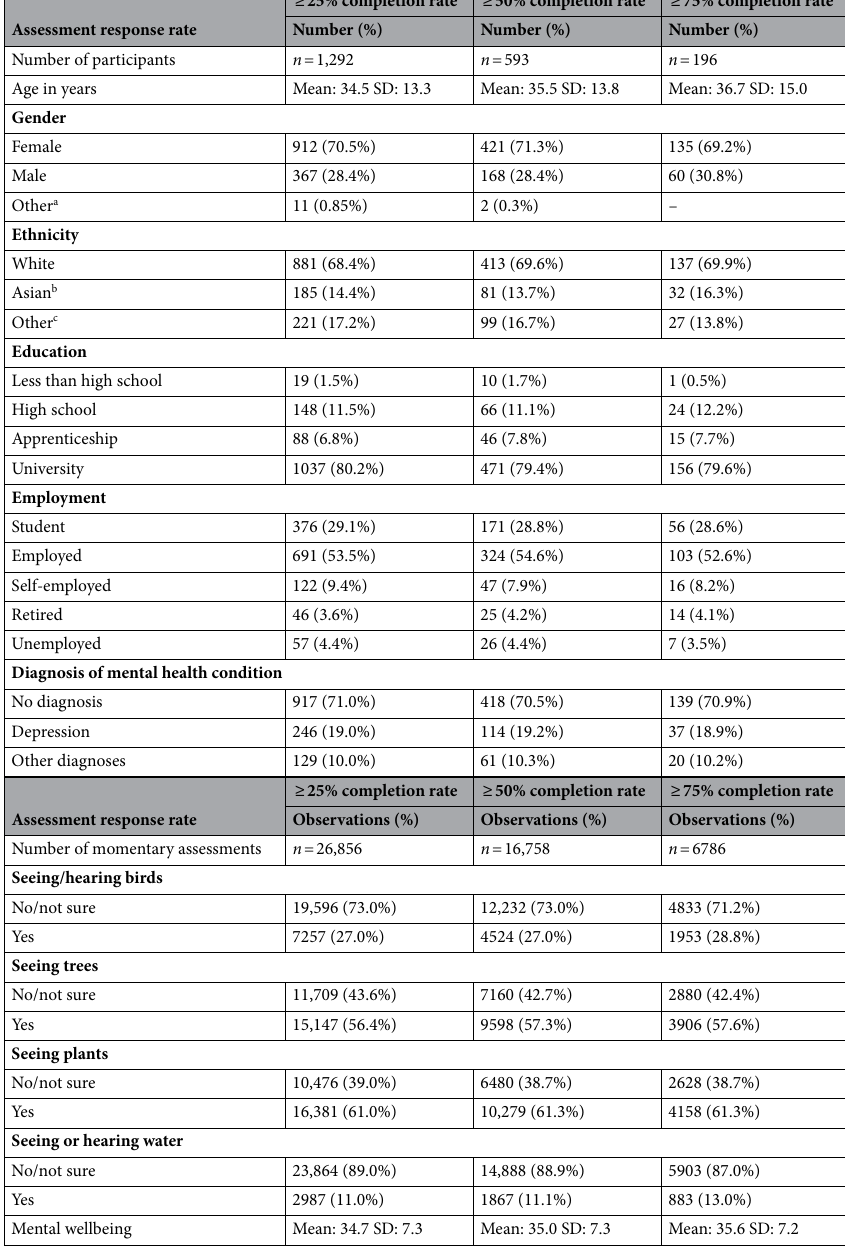
Table 1. Sociodemographic characteristics of participants. Numbers and percentages may not add up due to missing values. a Other: non-binary and other. b Asian: including Bangladeshi, Chinese, Indian, Pakistani, Japanese, Taiwanese, and Other Asian. c Other: including black, caribbean, latino or hispanic, indigenous, arab, other people of colour and